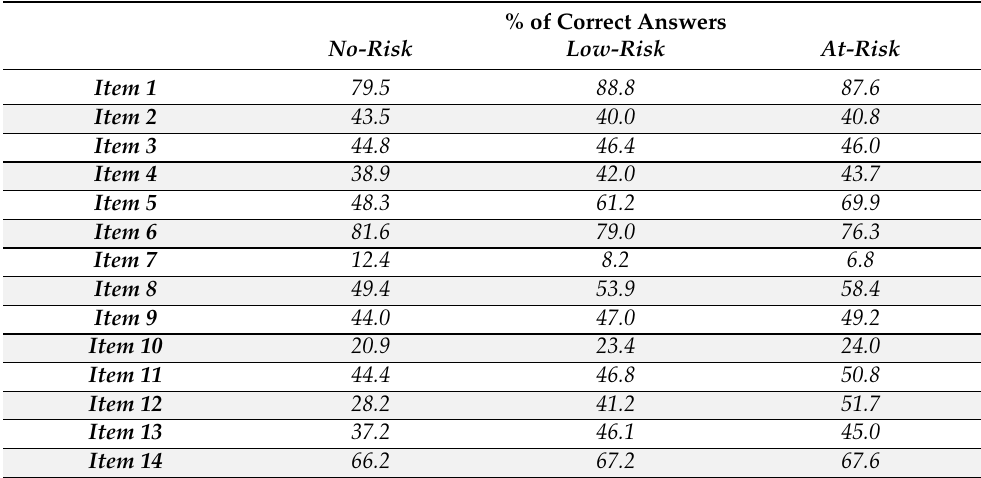
Table 5. Percentage of correct answers to the knowledge about alcohol and FASD between groups of drinking-risk according to the AUDIT-C (World Health Organization, 2000. International guide for monitoring alcohol consumption and related harm. World Health Organization. https://apps.who. int/iris/handle/10665/66529) (accessed on 8 August